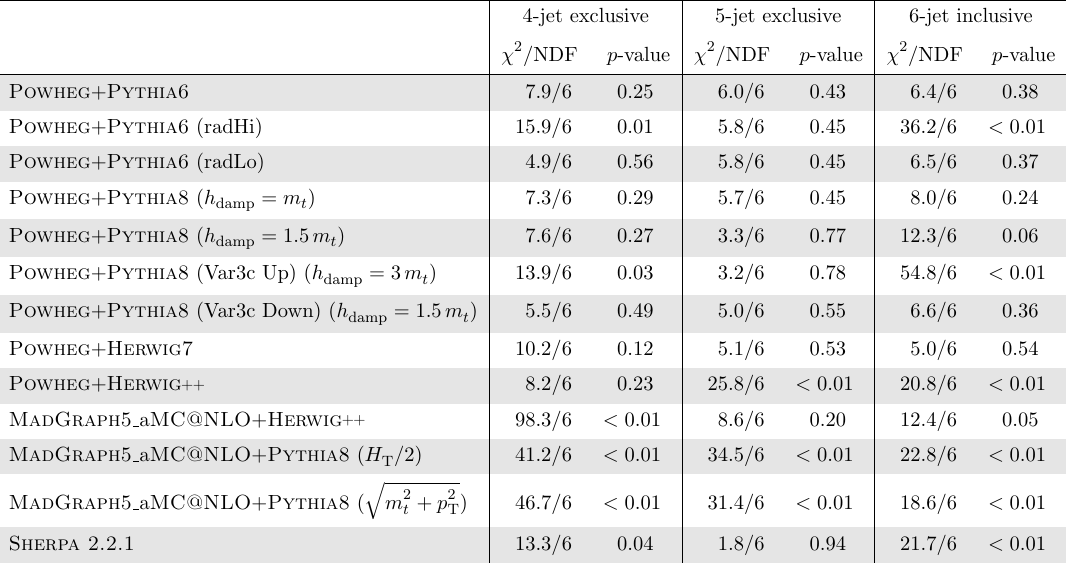
Table 5 . Comparison of the measured (cid:12)ducial phase space absolute di(cid:11)erential cross sections as a function of p t (cid:22) t and the predictions from several MC generators in di(cid:11)erent n -jet con(cid:12)gurations. T For each prediction a (cid:31) 2 and a p -value are calculated using the covariance matrix of the mea- sured spectrum. The number of degrees of freedom (NDF) is equal to the number of bins in the